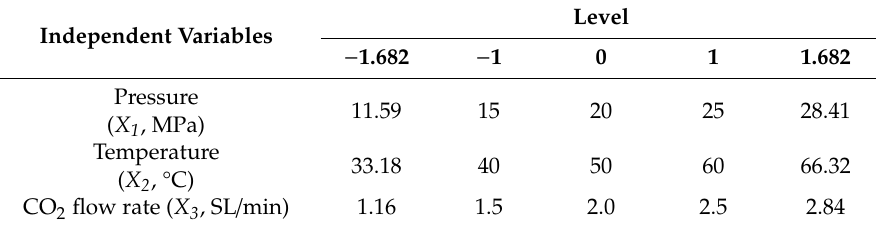
Table 7. Independent variables and their levels used in the response surface